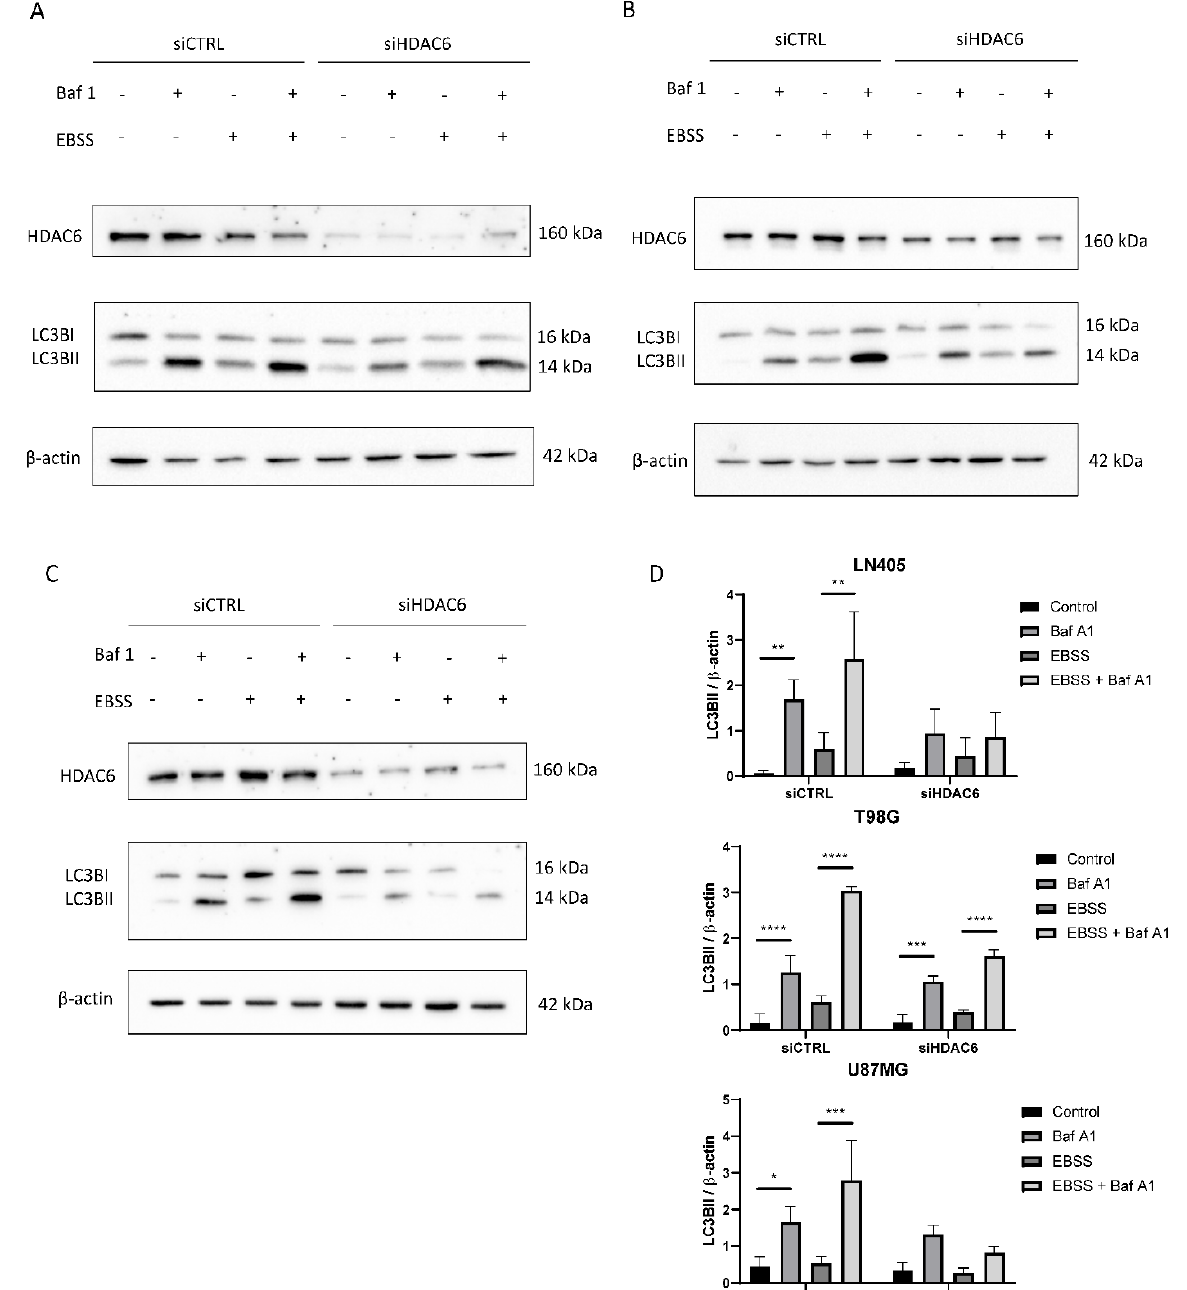
Figure 10. HDAC6 silencing decreases the autophagic flux in GBM cell lines. ( A – C ) Representative image of western blot of HDAC6, LC3B, and β -actin after 100 nM Baf A1, EBSS, EBSS + Baf A1, or DMSO (as vehicle control treatment) for 6 h in ( A) LN405, ( B ) T98G, and ( C ) U87MG cell lines. ( D ) Analysis of LC3BII western blot. Data are represented as mean ± SD (*) p < 0.05, (**) p < 0.01, (***) p < 0.001, (****) p < 0.0001 ( n =